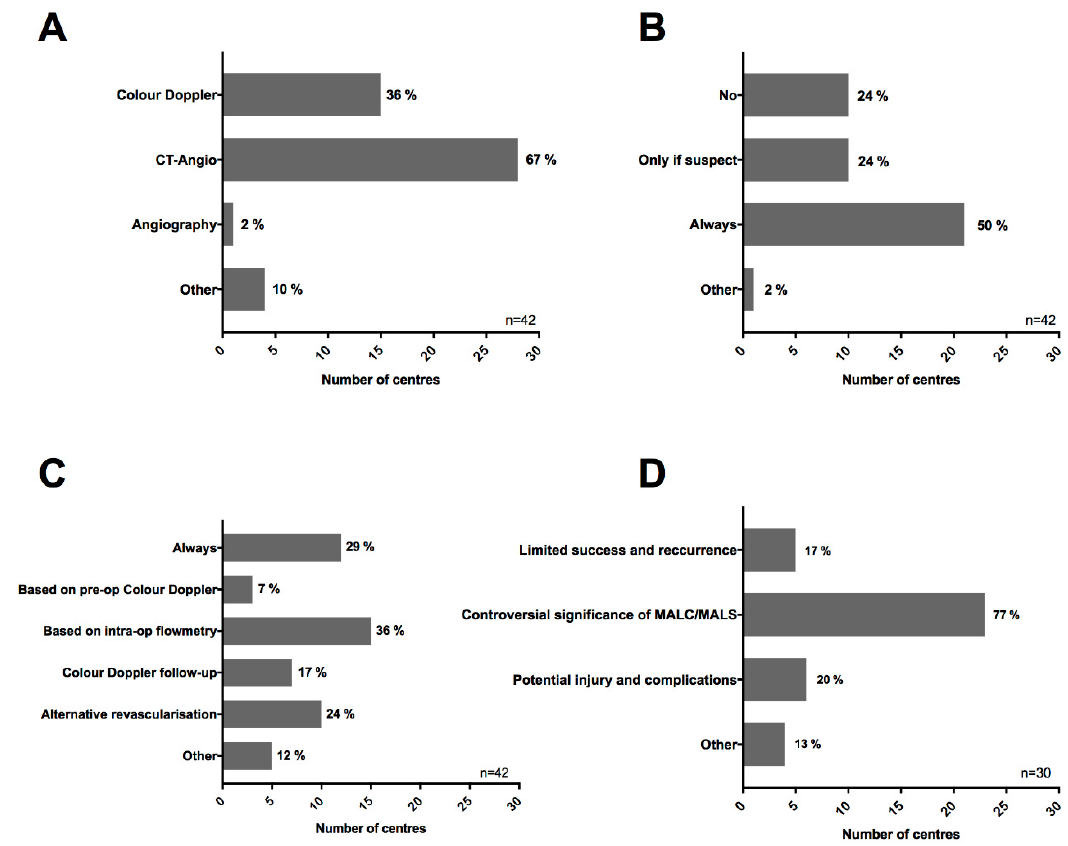
Figure 3. Survey results. Our survey was sent to the clinical leads of 52 European liver transplantation centers. The survey sought information on the local approaches on the diagnostics of vascular aberrancies and the treatment of MALC. Forty-two centers gave a valid response (81%; 42 / 52). ( A ) Which approach do you routinely use in pre-operative imaging of recipient vascular anatomy? ( B ) Do you routinely look for potential anatomical compression or kinking of the celiac axis in sagittal reconstruction of the CT-scans? ( C ) What is your institutional protocol in cases where you find a suspected anatomical compression of the celiac axis in the pre-operative diagnostics (e.g., Dunbar-syndrome)? ( D ) If you do not routinely divide the MAL in cases of a suspected MAL syndrome what is the main reason behind it? During the assessment of question D, centers which reported at question C that they always divide the MAL in MALC were excluded. Abbreviations used: CT, computed tomography; CD, color Doppler; MALC, median arcuate ligament syndrome / Dunbar syndrome.